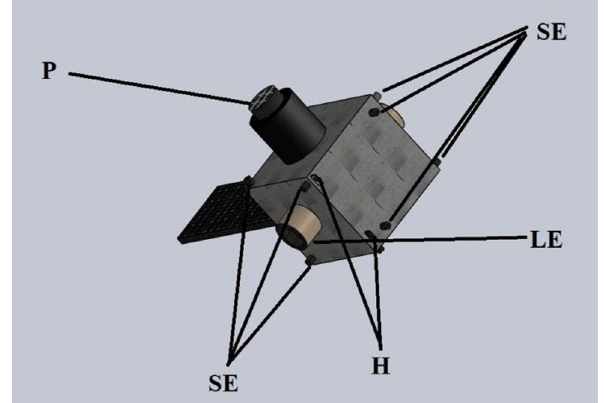
Figure 5: Rear view 2 of the micro/nanosatellite. SE: small - thrust engine; H: hook system for the removal net and node satellite; LE: large - thrust engine; and P: remote sensing payload.